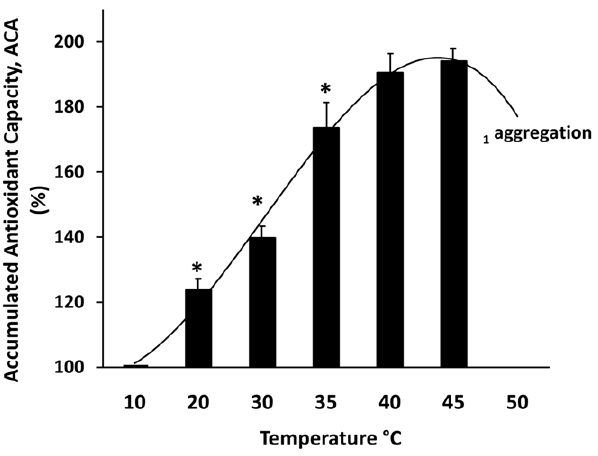
Figure 3. Antioxidant changes (RS) induced previous thermal denaturation. A cyclic pattern of antioxidant changes may be observed just before protein aggregation. Protein stock solutions (100 mg/ml) were placed at 65 6 0.1 u C and samples were collected several seconds before the denoted protein aggregation (scattering at 400 nm). A characteristic cyclic pattern of increased and decreased antioxidant capacity could be observed before protein aggregation. The antioxidant capacity (AC) of the albumin previously placed at 65 u C was 94 nM TEU and corresponds to 100% of ACA%. RS correspond to ACA%-100 as specified in the Material and Methods section. The increase and decrease of ACA did not exceed 10% of the base antioxidant level. The graph corresponds to a representative experi- ment. 1 Temperature for aggregation is concentration-dependent (more details in the text).